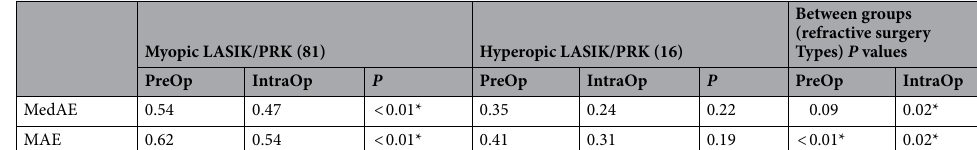
Table 4. Comparison of predictive refraction errors based on refractive surgery type. The intraoperative method performed better than the preoperative method in predictive refractive accuracy in patients with a history of myopic LASIK/PRK in comparison to those with a history of hyperopic LASIK/PRK. LASIK laser in situ keratomileusis, PRK photorefractive keratectomy, MedAE median absolute error, MAE mean absolute error, PreOp preoperative method, IntraOp intraoperative method; *statistically